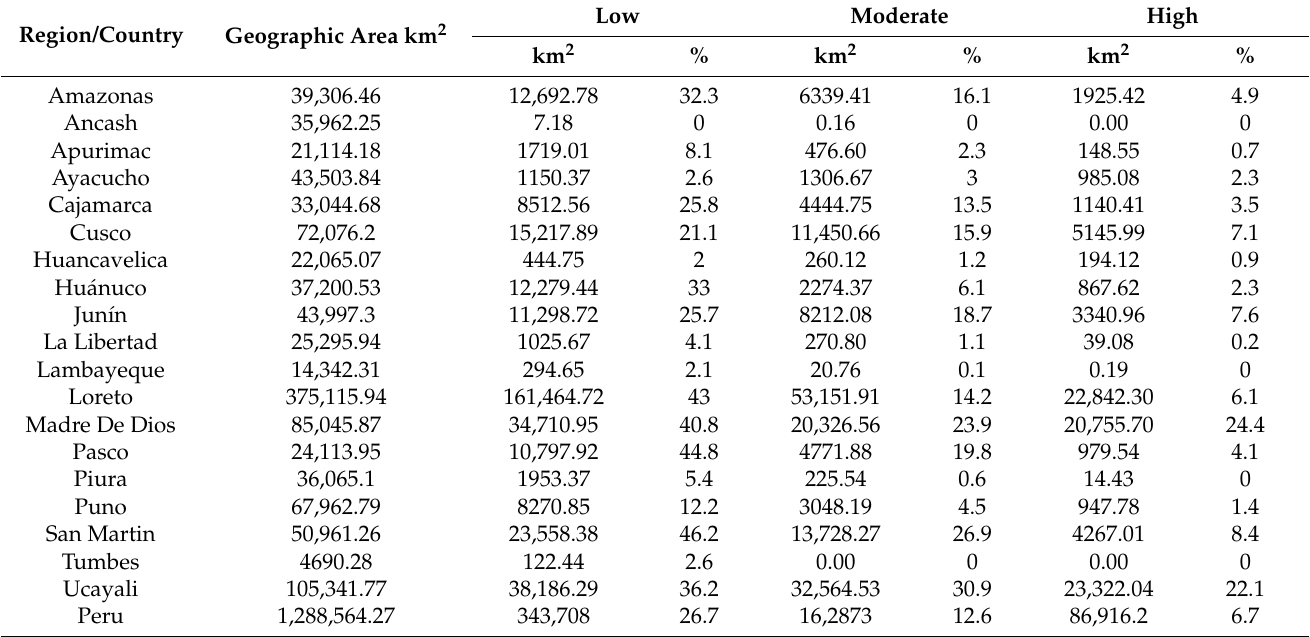
Table 4. Area of distribution of the biographical model of the genus Cedrela in Peru.